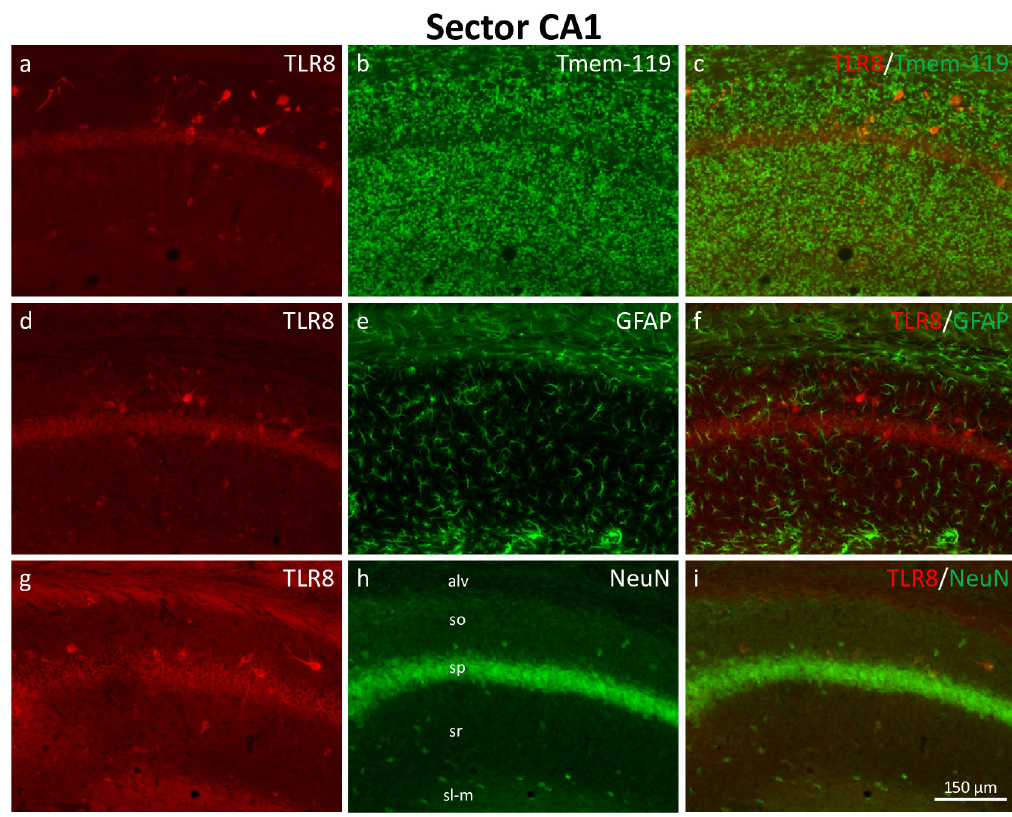
Fig 5. Expression of TLR8 in hippocampal sector CA1. Double-immunofluorescence of TLR8 together with Tmem-119 (microglial marker, a-c), GFAP (astrocyte marker, d-f), and NeuN (neuronal marker, g-i). TLR8 was expressed in presumed GABAergic interneurons in stratum oriens, stratum pyramidale, stratum radiatum, and stratum lacunosum-moleculare of sector CA1 (a, d, g). Weaker TLR8-labeling was present in CA1 principal neurons in stratum pyramidale. Co-labeling with Tmem-119, GFAP, and NeuN revealed that TLR8 expression in sector CA1 was restricted to neurons (i). Abbreviations: alv, alveus; so, stratum oriens; sp, stratum pyramidale; sr, stratum radiatum; sl-m, stratum lacunosum-moleculare.